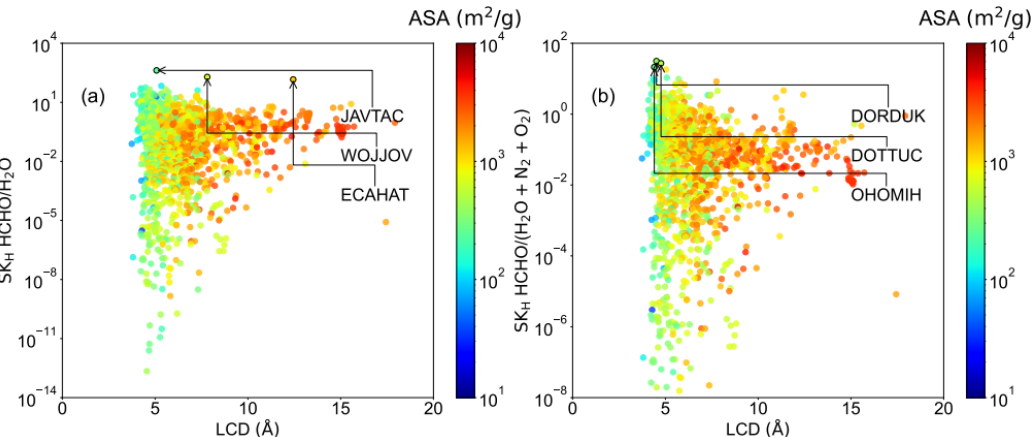
Figure 5. Relationship between LCD and ( a ) SK H HCHO/H 2 O, ( b ) SK H HCHO/(H 2 O + N 2 + O 2 ), colored by the ASA.